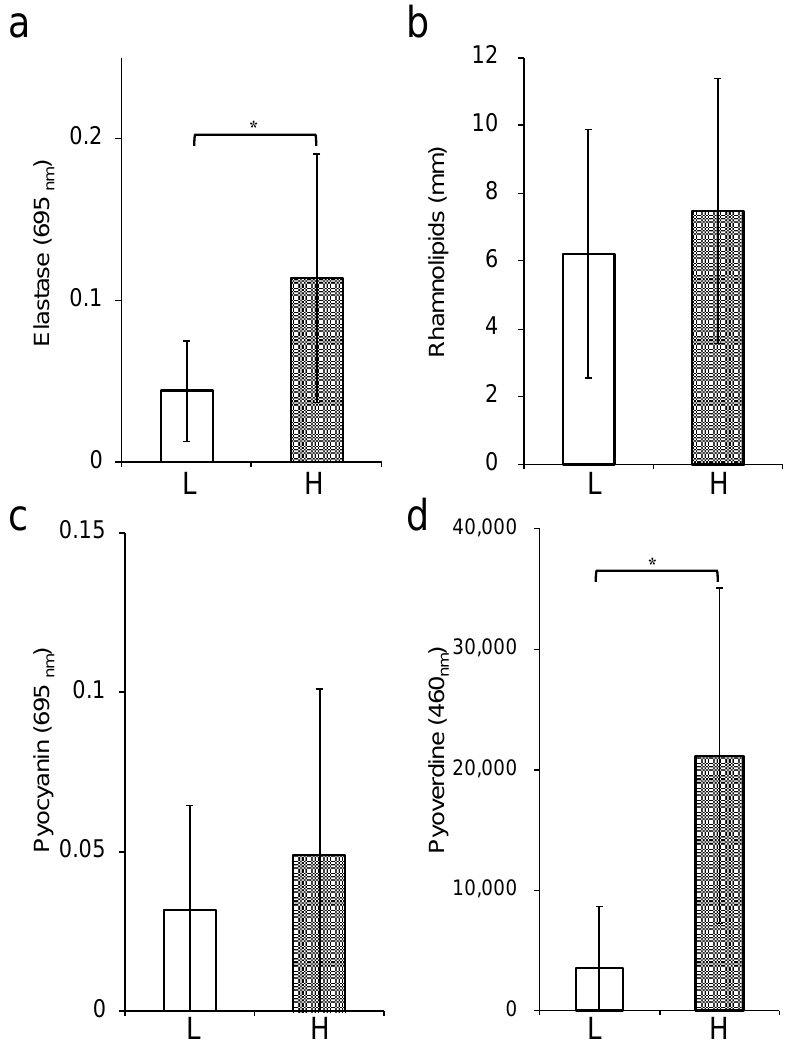
Figure 4. Bacterial virulent factors production in the low- and high-tolerance groups. Elastase production ( a ), rhamnolipid production ( b ), pyocyanin production ( c ), and pyoverdine production ( d ) are shown. The white bars represent the low-tolerance group ( n = 6), and the black bars represent the high-tolerance group ( n = 9). Each experiment was performed in triplicate. The data are presented as the mean ± SD for three experiments (* p < 0.05 compared to the low-tolerance group).